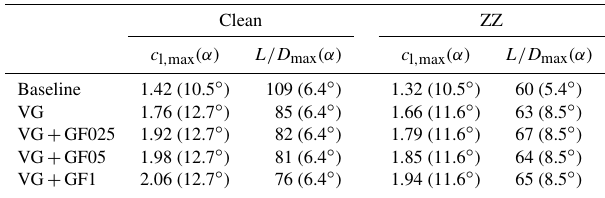
Table B1. NACA63(3)618. Vortex generators plus Gurney flaps. Characteristic values.